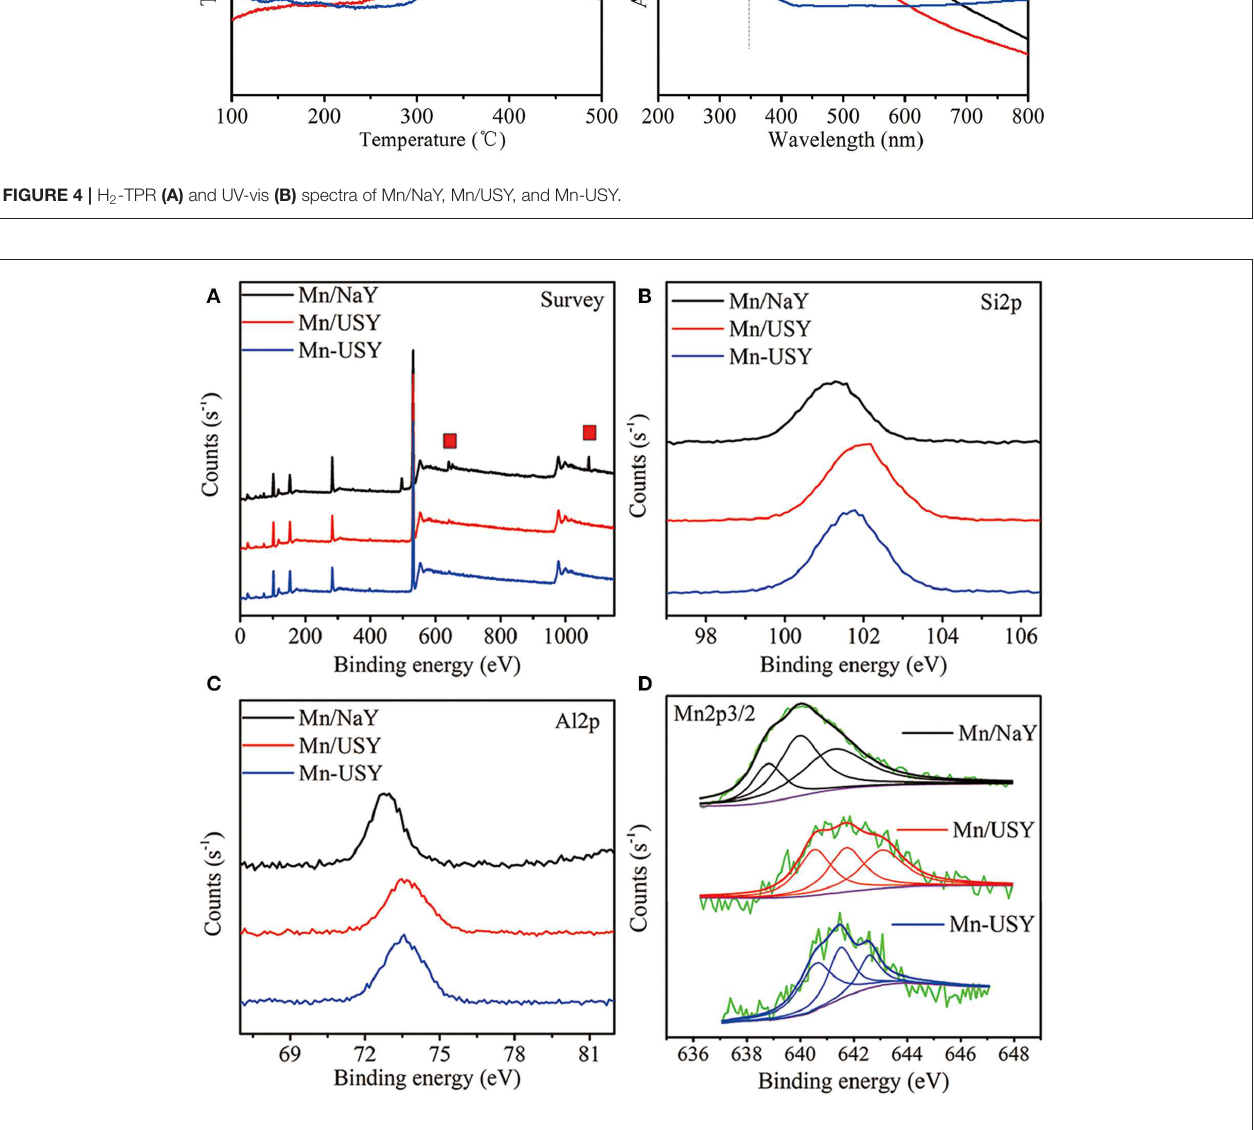
FIGURE 5 | Survey (A) , Si2p (B) , Al2p (C) and Mn2p (D) XPS spectra of Mn/NaY, Mn/USY and Mn-USY.